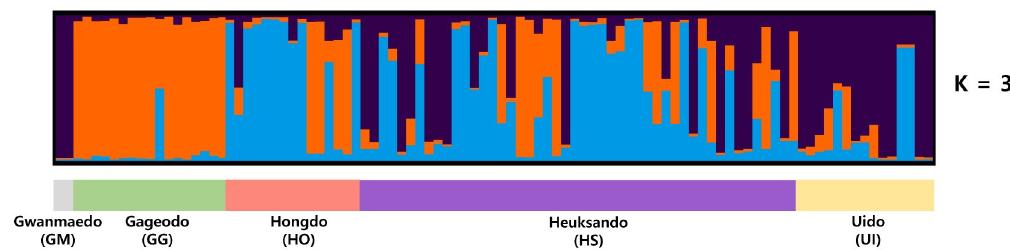
Fig 5. STRUCTURE bar plot of 97 individuals of Saussurea polylepis from five populations at K = 3. Color indicates different clusters.